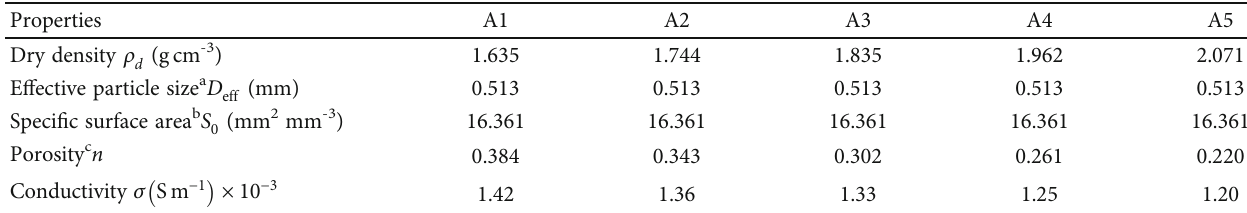
Figure 3: The streaming potential coupling coe ffi cient and the e ff ective excess charge density. (a) The streaming potential against hydraulic head di ff erence at 85% compactness and 30% rock content. The streaming potential coupling coe ffi cient is the slope of the regression line between streaming potential and hydraulic head di ff erence. (b) The e ff ective excess charge density versus permeability. The e ff ective excess charge density is calculated by Equation (2). Table 5: Properties of SRM with di ff erent compactness.